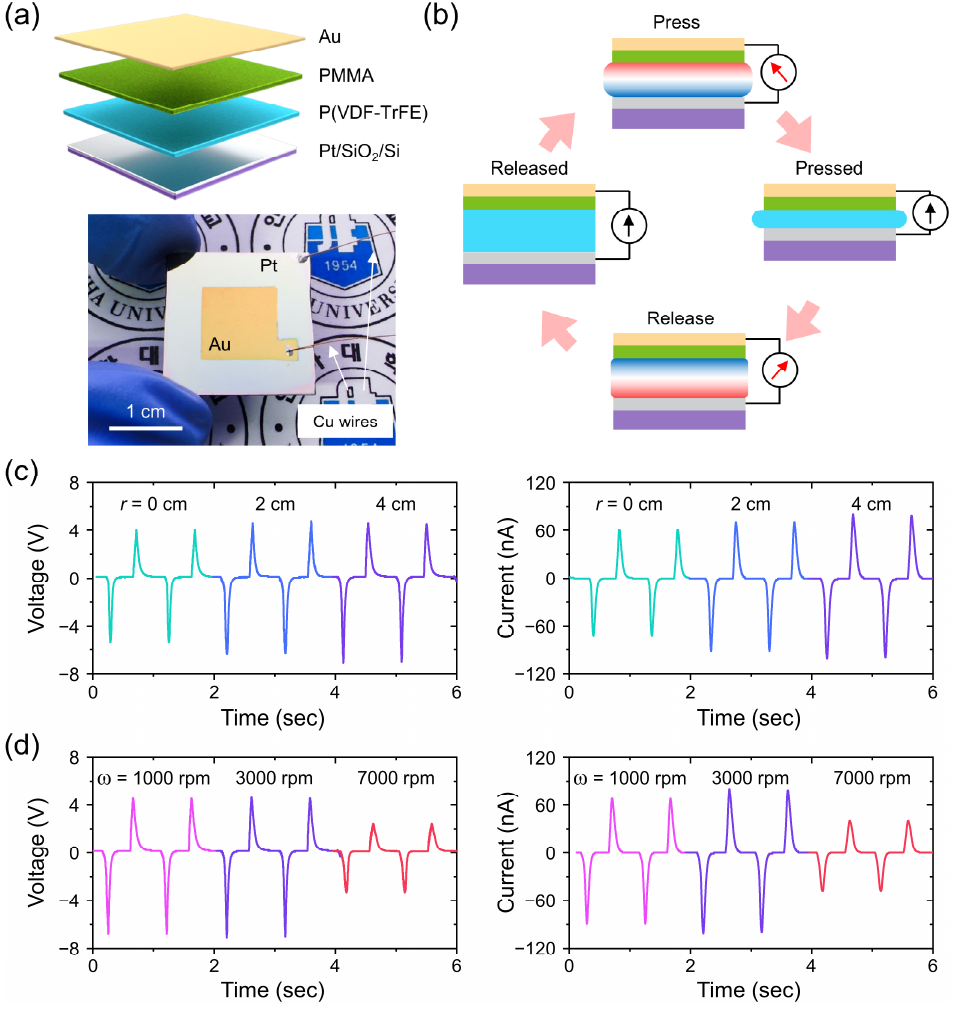
Figure 5. ( a ) Schematic diagram and a digital image, and ( b ) power generation mechanism of a P(VDF-TrFE)-based piezoelectric nanogenerator (PENG) during one cycle of the pressing and releasing process. ( c ) Distance- and ( d ) rotational speed-dependent open-circuit voltage and short- circuit current. In ( a ), two Cu wires were attached to Au as a top electrode and Pt as a bottom electrode. In ( b ), the gradient red-white-blue color represents the piezoelectric potential, induced during press and release of P(VDF-TrFE) film.